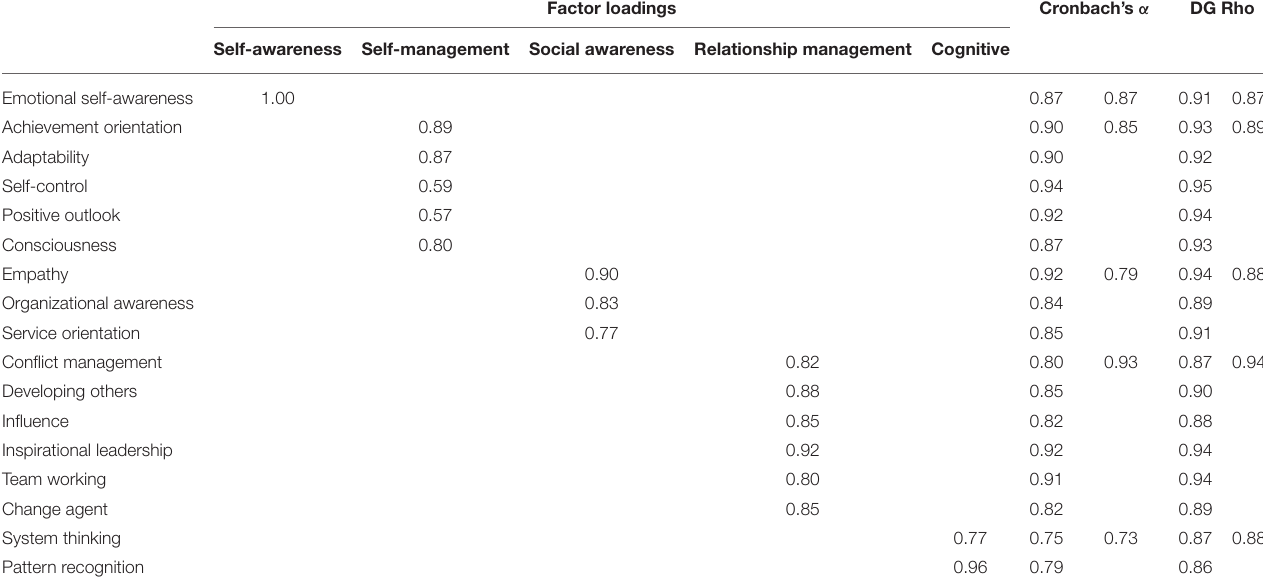
TABLE 5 | Measurement model.